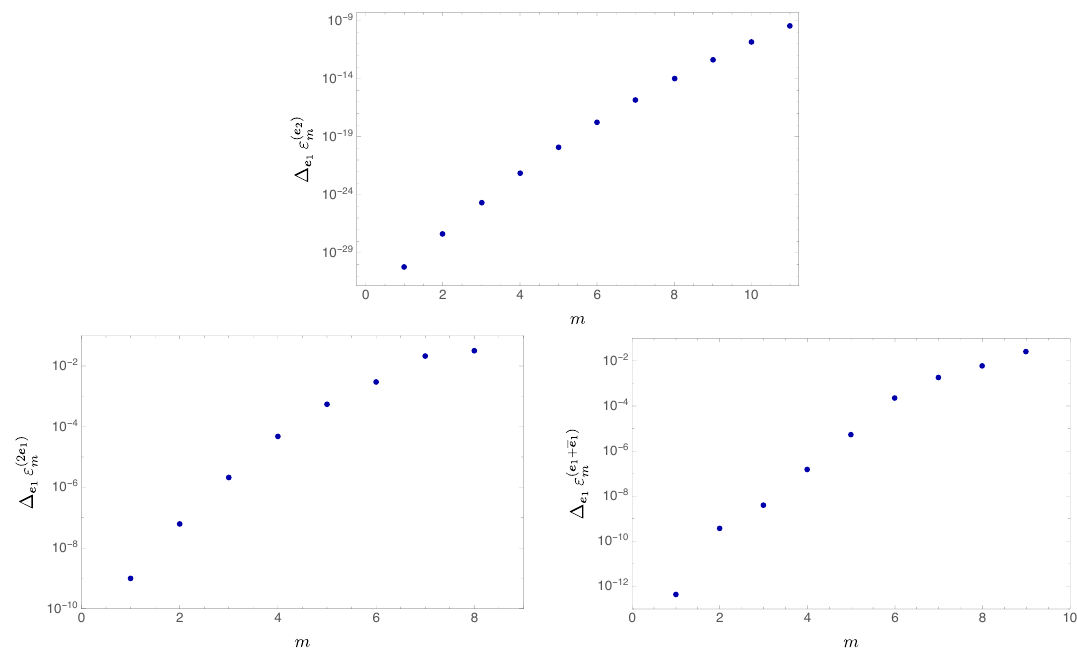
Figure 5 . Comparison of the predicted results from resurgence techniques and the numerical ones obtained from solving Einstein equations. In the above plots we show this comparison for the coe(cid:14)cients of the fundamental sector (cid:8) e and mixed sectors (cid:8) 2 e and (cid:8) e , as predicted by their 2 1 1 + e 1 relation to sector (cid:8) e (following eq. 1